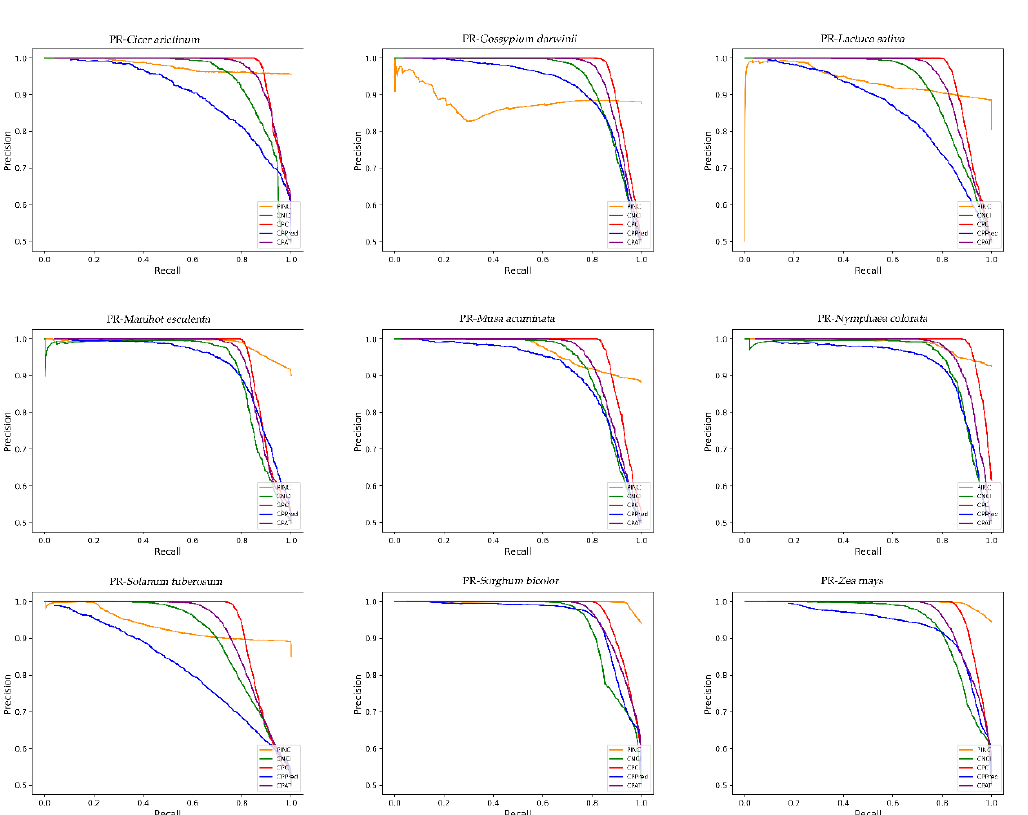
Figure 6. The PR curves obtained by PINC and four existing